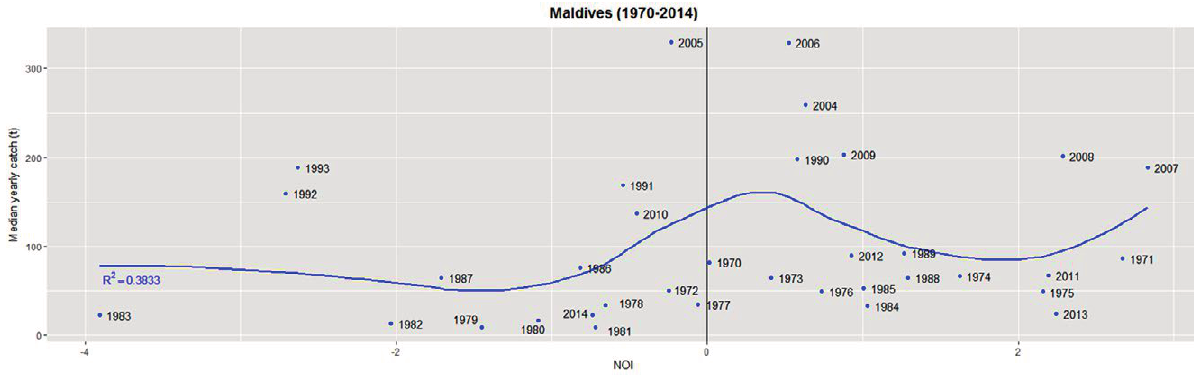
Fig. 13. – Median yearly skipjack catch in the Maldives as a function of NOI signal, adjusted with a non-linear parametrized curve (rs=0.609*,